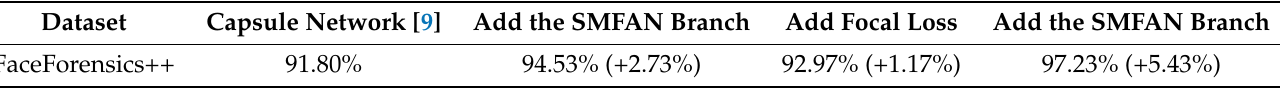
Table 5. Comparison of accuracy of introducing the SMFAN branch and focal loss on the FaceForensics++ dataset.